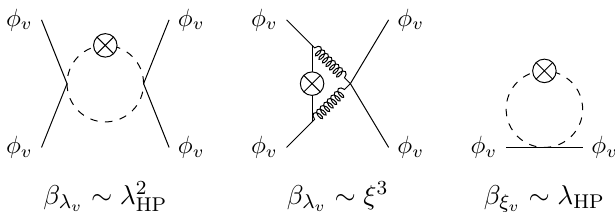
Figure 6 . Diagrams representing different contributions of the portal coupling λ HP to the beta function of the visible quartic self-coupling λ . A solid line represents the visible scalar, a dashed line v the dark scalar, and a wavy line the graviton propagator respectively. The cross vertex corresponds to a regulator insertion. For each of the diagrams, there are corresponding diagrams of the same structure with regulator insertions on one of the other internal lines. (a) Direct contribution ∼ λ 2 HP from dark scalar loop. (b) Indirect contribution from graviton triangle which is odd in the non- minimal coupling ξ , whose beta function in turn has a contribution (c) odd in λ (the same HP remark applies, to the flow of squared scalar masses, but typically m 2 (cid:28) ξ v,d ∗ by roughly an v,d ∗ order of magnitude).